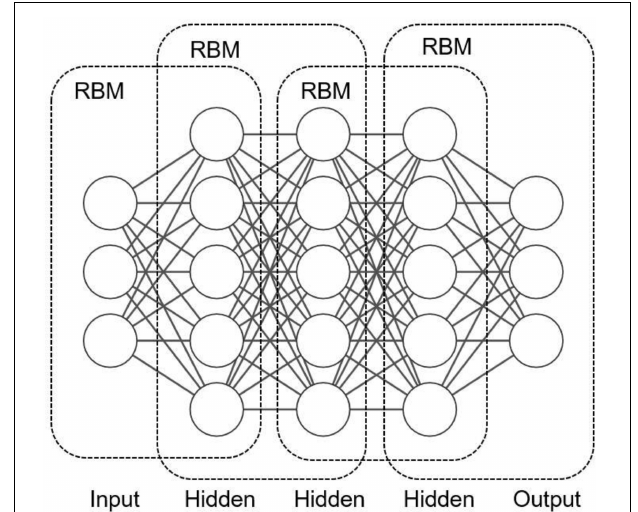
FIGURE 9 | Illustration of deep belief network.